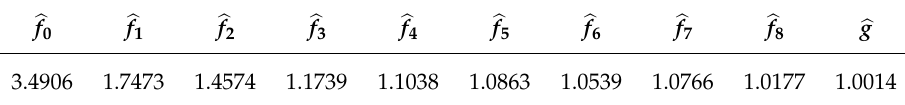
Table 2. Estimated parameter values for the dataset of Taylor and Ashe (1983).